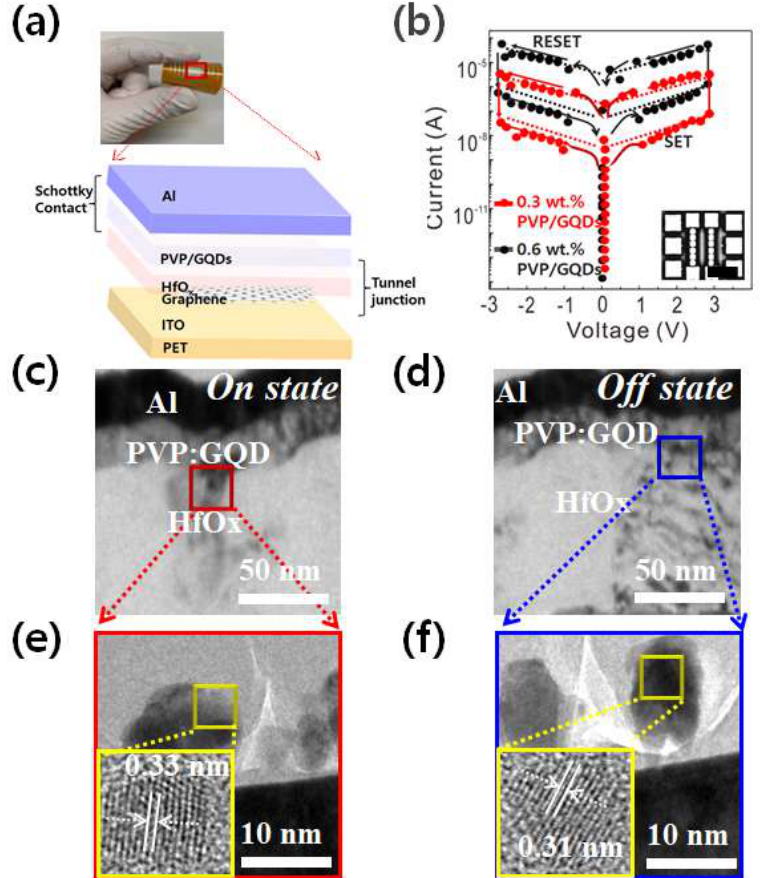
Figure 2. ( a ) Schematic illustrating the flexible device structure with PVP GQD layer; ( b ) I–V curves of Al/PVP GQD/HfOx/ITO/graphene/PET memory devices plotted on a semi-logarithmic scale. The inset is an optical microscopy image of Al/PVP GQD/HfOx/ITO/graphene device (scale bar: 200 µm). Cross-sectional TEM images of ( c ) conductive channel region at the ON state and ( d ) the OFF state; ( e , f ) corresponding cross-sectional HR-TEM images obtained in the red and blue rectangular region of ( c , d ), respectively.